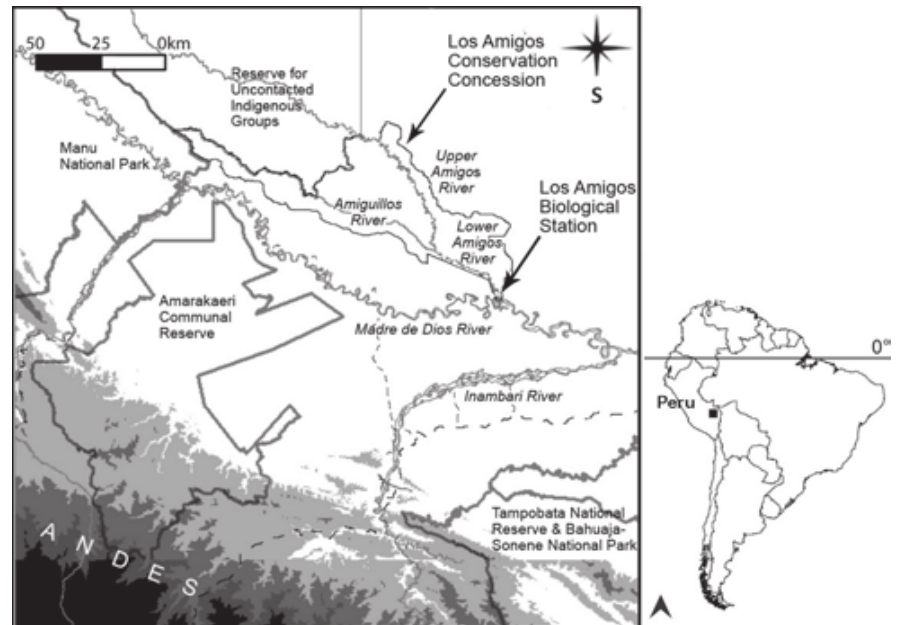
Figure 1. A map of the study area in southeastern Peru showing location of river sections surveyed. The white portion of the map is below 500 m elevation; darker gradations show 500-m intervals. Dotted lines represent roads. Several rivers have been omitted for